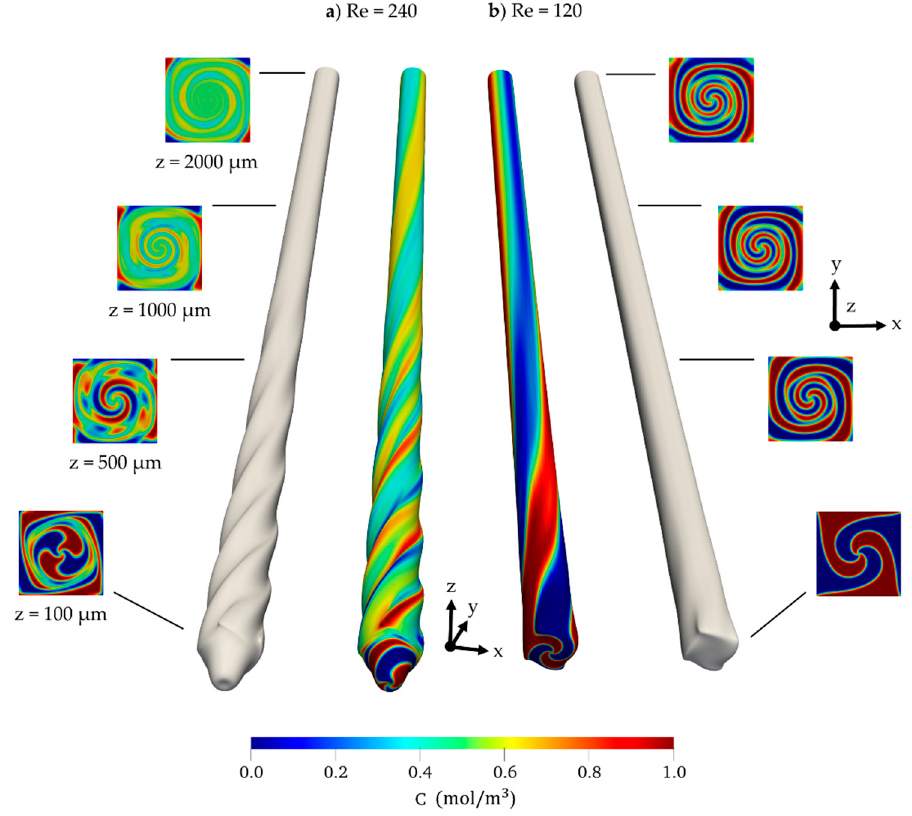
Figure 10. Fluid flow and scalar transport in the mixing channel of the four-inlet design: ( a ) Re = 240 (left two shapes) and ( b ) Re = 120 (right two shapes). Colored images show scalar transport at the M1 mesh level.